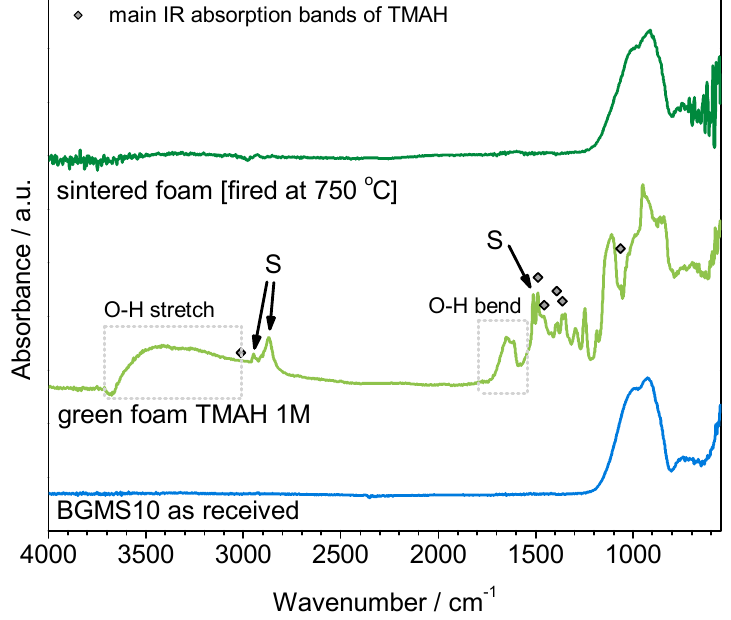
Figure 6. FTIR spectra of BGMS10 before and after activation and after firing.